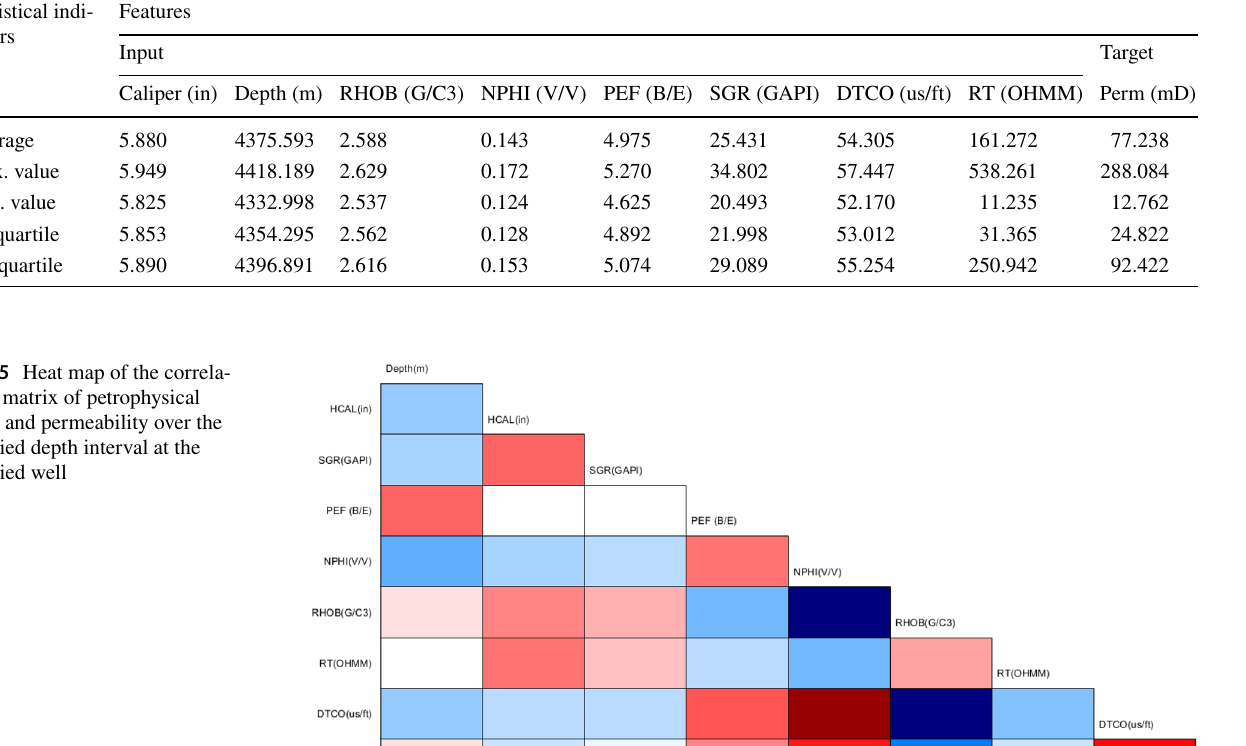
Table 3 Statistics on the collected data over the studied depth interval at the studied well B Statistical indi- cators